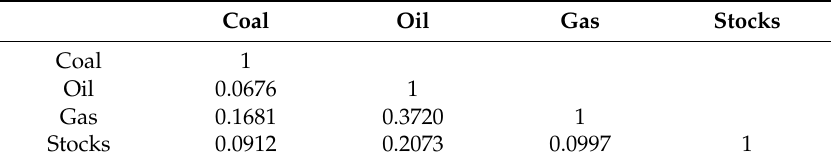
Table 6. Correlations for Canada.